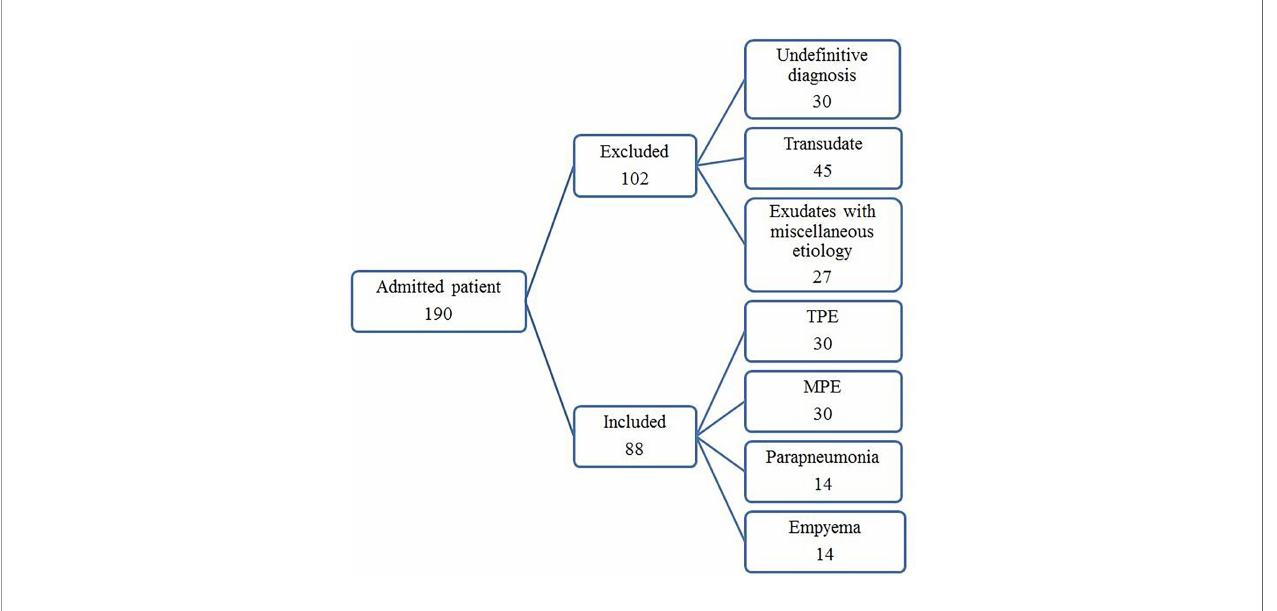
FIGURE 1 | Flowchart.